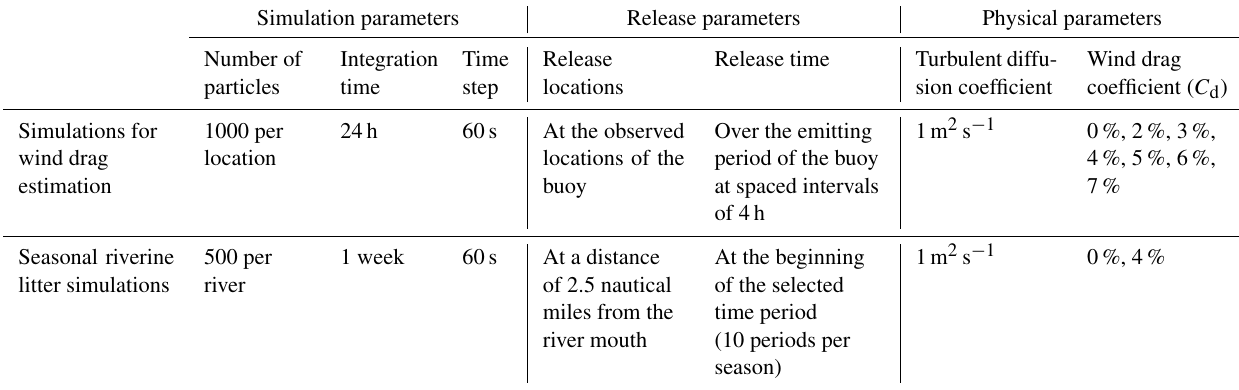
Wind drag coefficient ( C d ) 4%, 5%, 6%, 7%